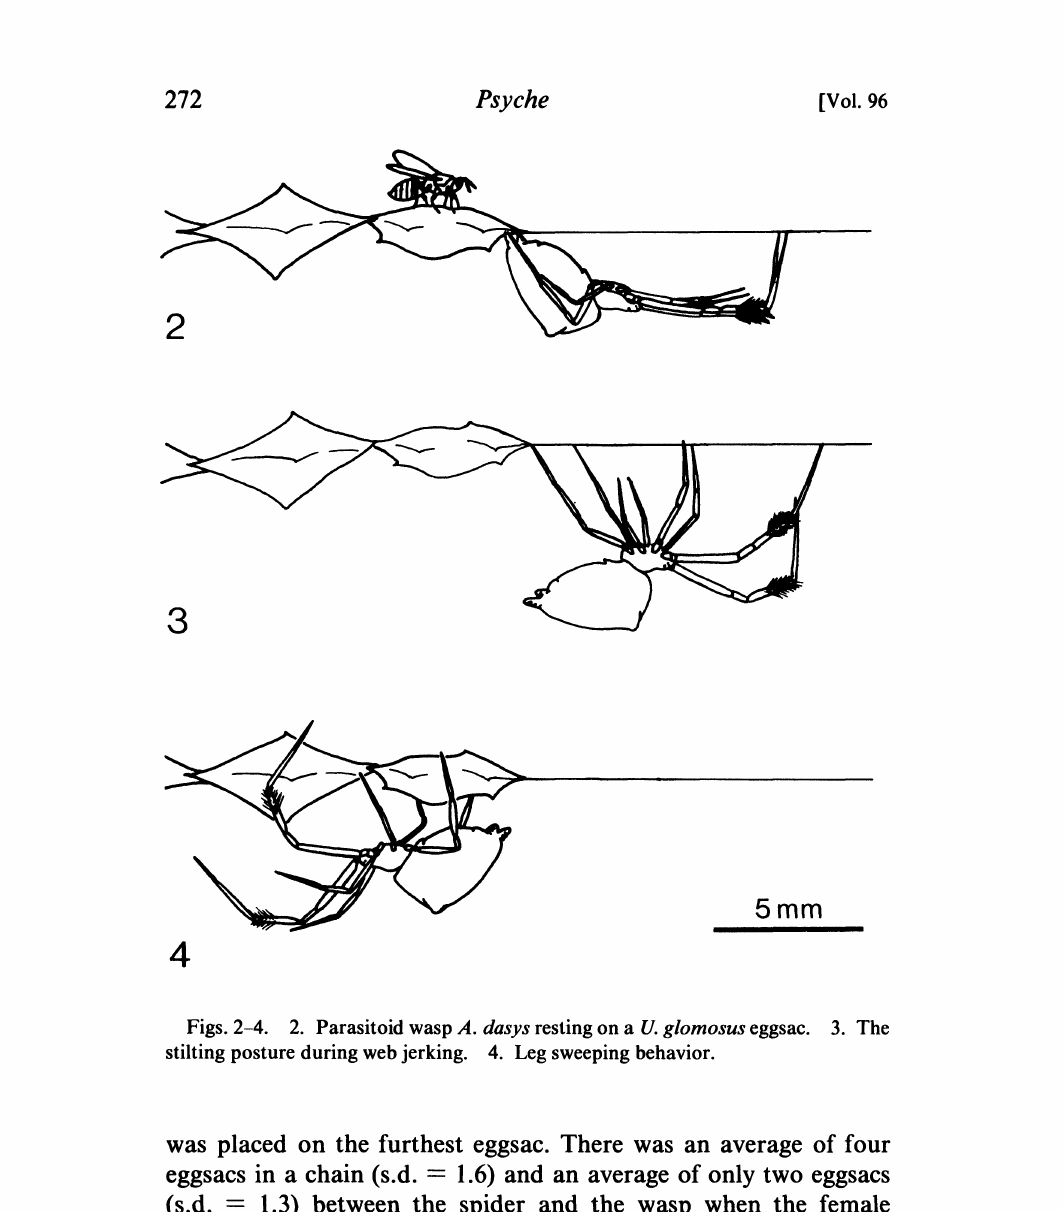
Figs. 2-4. 2. Parasitoid wasp A. dasys resting on a U. glomosus eggsac. 3. The stilting posture during web jerking. 4. Leg sweeping